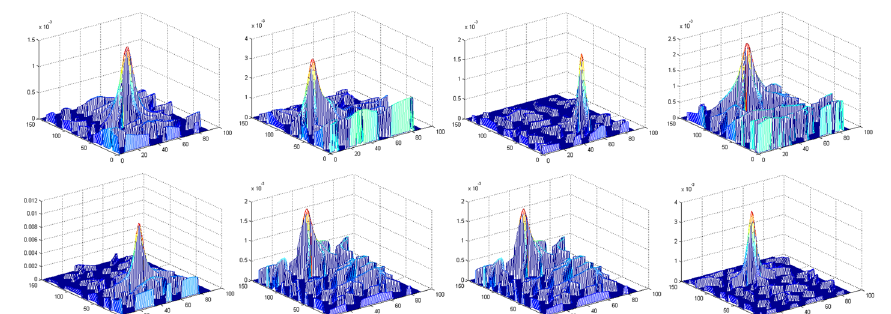
Fig. 13 Matching correlation surfaces under translational